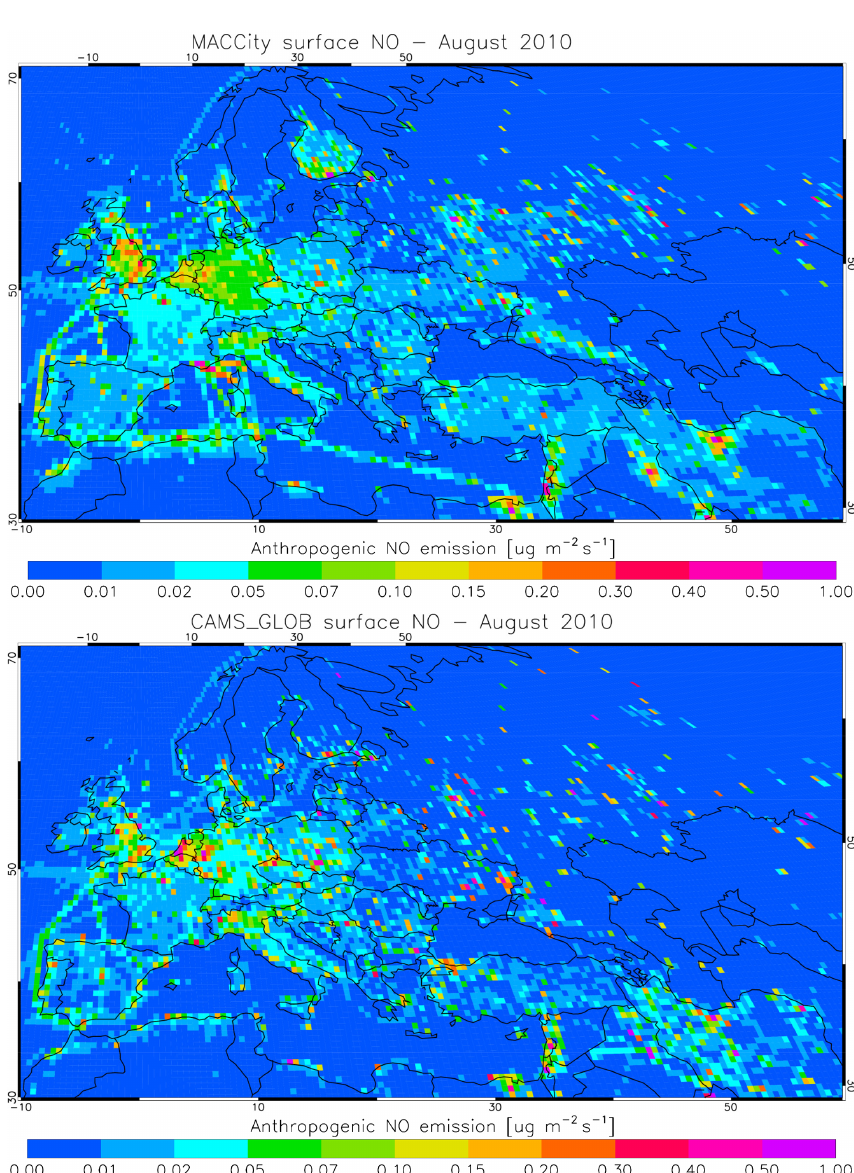
Figure A1. MACCity and CAMS_GLOB_ANT v2.1 anthropogenic surface NO x emissions (emitted as NO) for Europe in August